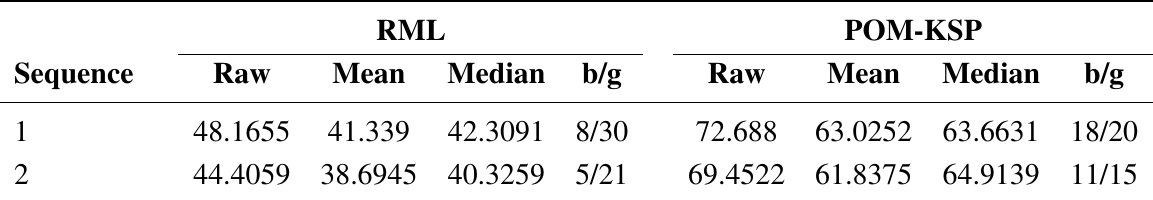
Table 1. Results for the RML and POM-KSP trackers. The table shows the TATE results for raw tracks and for tracks after simple smoothing using a mean filter and outlier removal using a median filter. The b/g column shows the number of bad and good tracks. RML